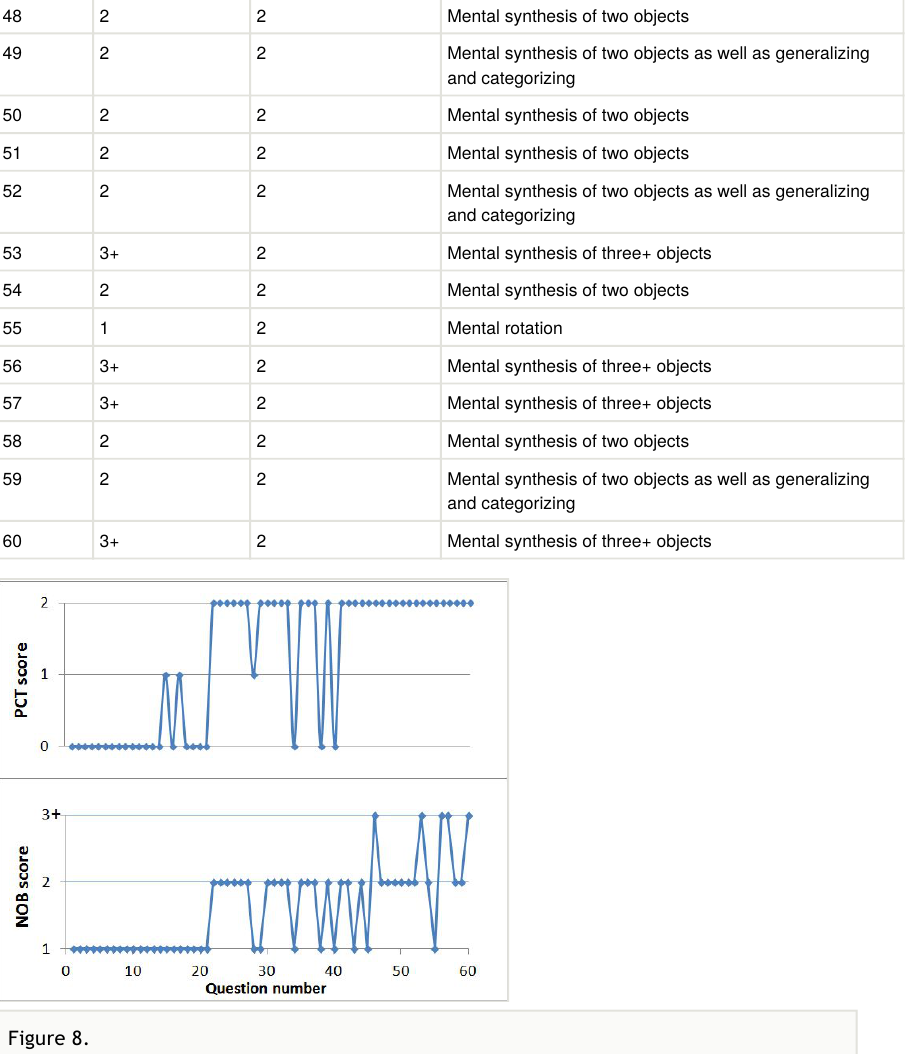
Graphical representation of neurobiological requirements for TONI-4, Form B. The NOB score (bottom) and the PCT score (top) as a function of question